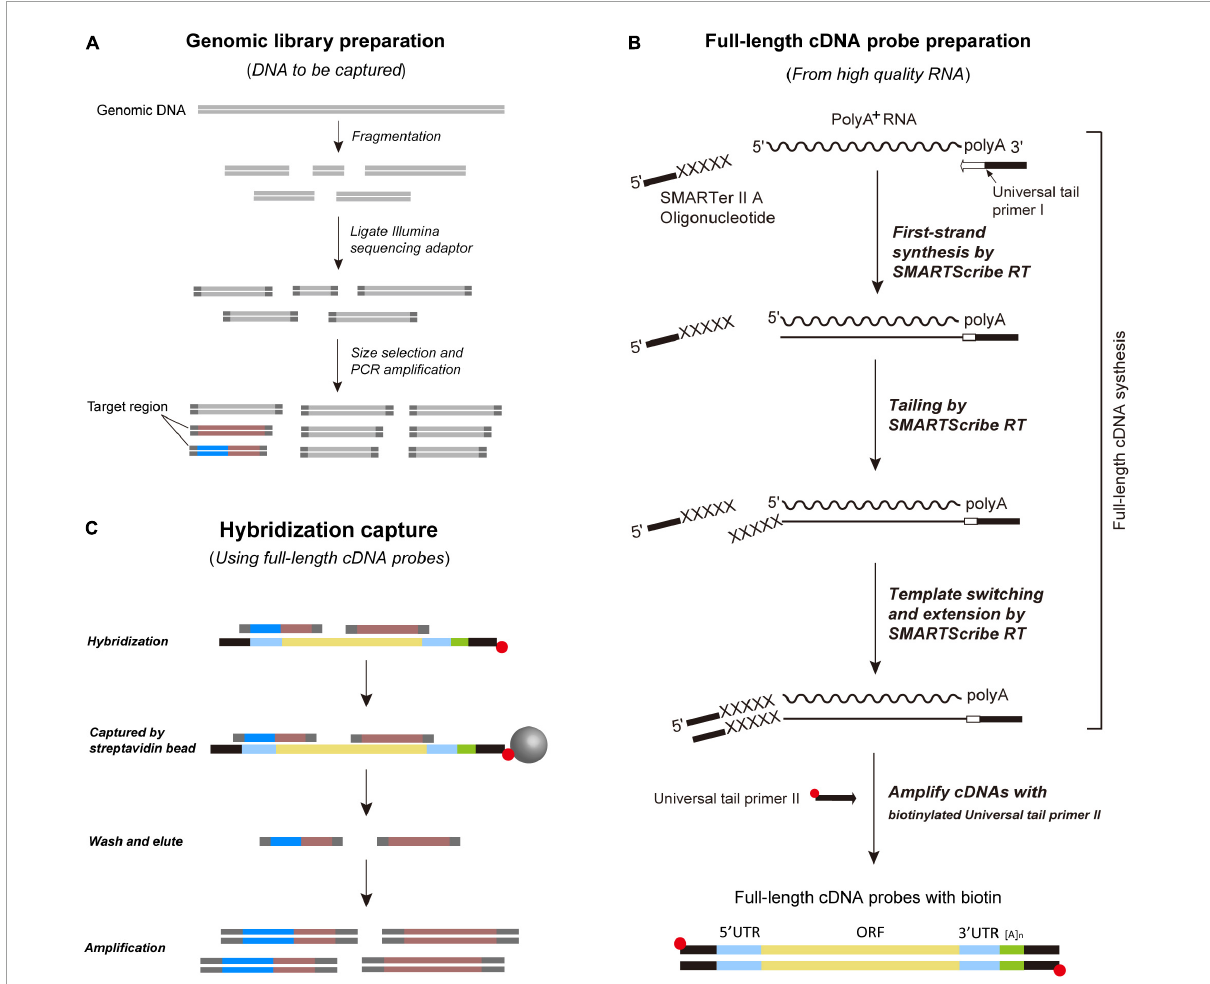
FIGURE1 Schematic overview of the FLc-Capture sequencing method. (A) Prepare shotgun genomic DNA library. (B) Prepare full-length cDNA probes from high-quality RNA using SMARTer TM PCR cDNA Synthesis Kit (Clontech Inc.). The full-length cDNA probes contain both UTR and ORF regions. (C) Hybridize the probes to the shotgun genomic library. Both coding and non-coding loci bind to the cDNA